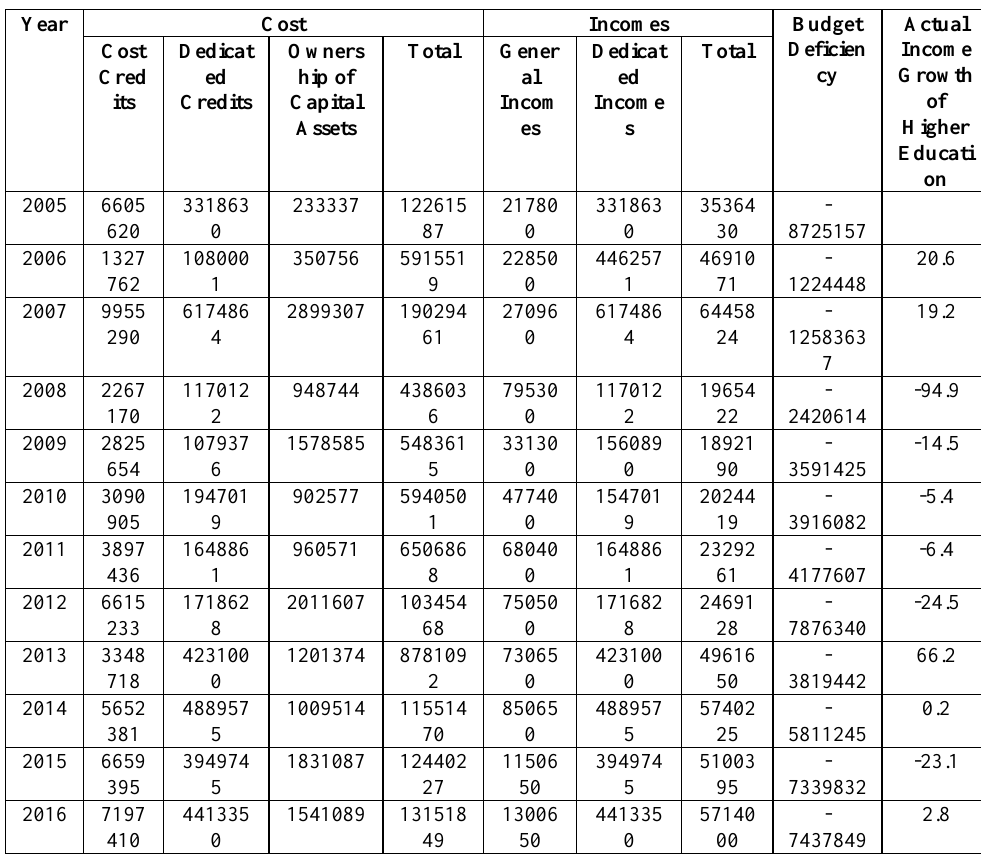
Table 1. Estimates of Credits and Incomes of Ministry of Science, Research, and